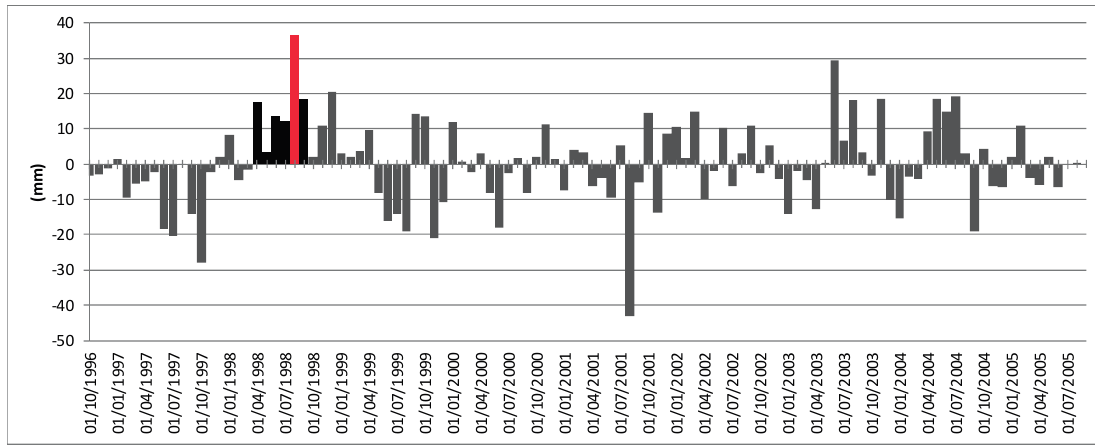
Figure 7. Divergence of monthly evaporation versus average evaporation for that month (grey), divergence in dry season with highest evaporation (black) and largest divergence from monthly average value (red).